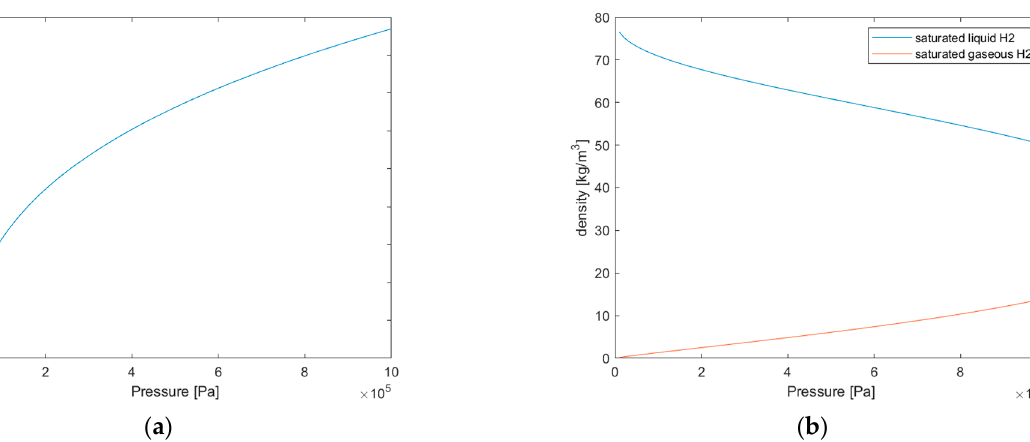
Figure 3. Temperature–pressure ( a ) and density–pressure ( b ) relations for saturated H 2 .